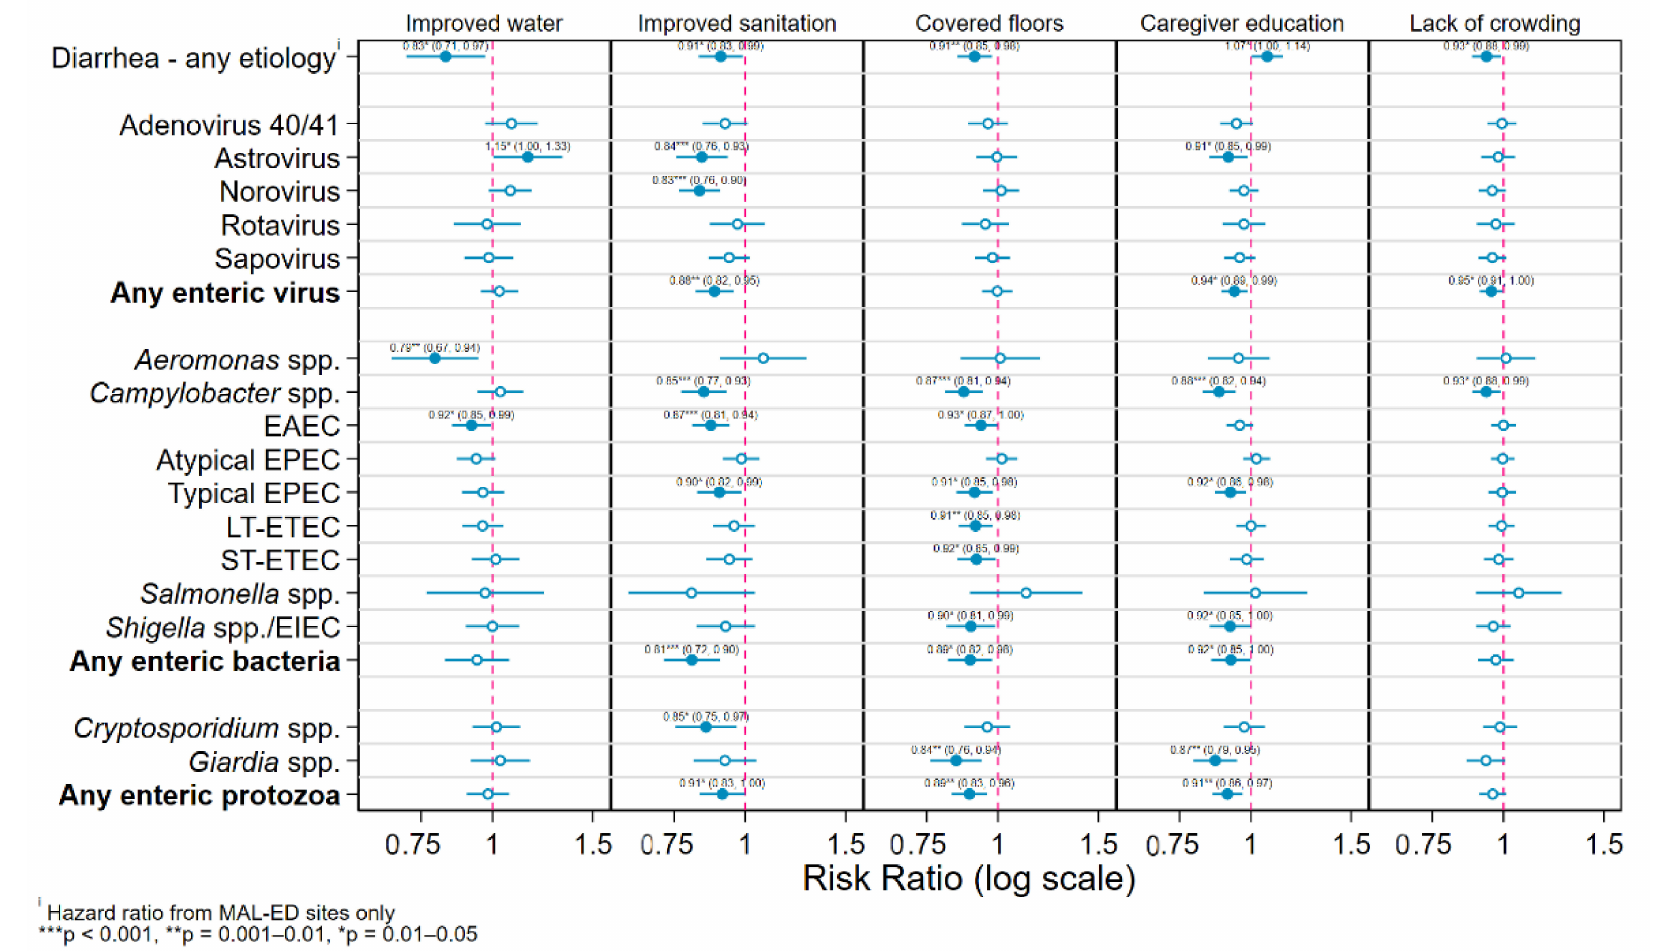
Figure 2. Hazard and risk ratios for detection of specific enteric pathogen species in stool samples associated with 5 household-level risk factors from Cox and generalized linear models adjusting for study site, age, sample type and feeding and nutritional